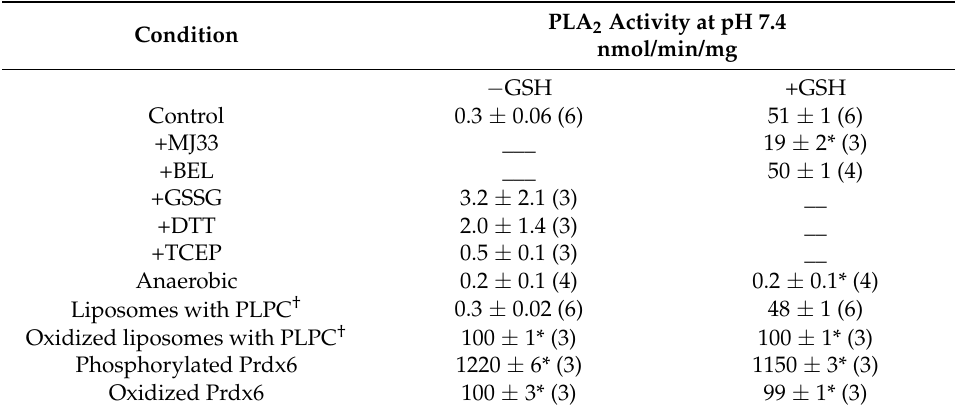
Table 1. Effect of protein and substrate modifications on phospholipase A 2 (PLA 2 ) activity of peroxiredoxin 6 (Prdx6) at pH